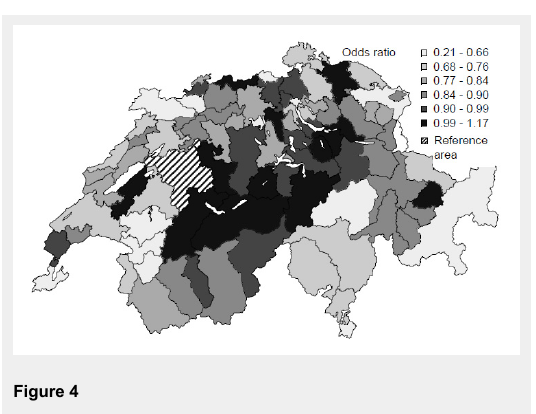
Odds ratios of health service areas for total hip replacements (2005). Odds ratios of health service areas for spinal surgery